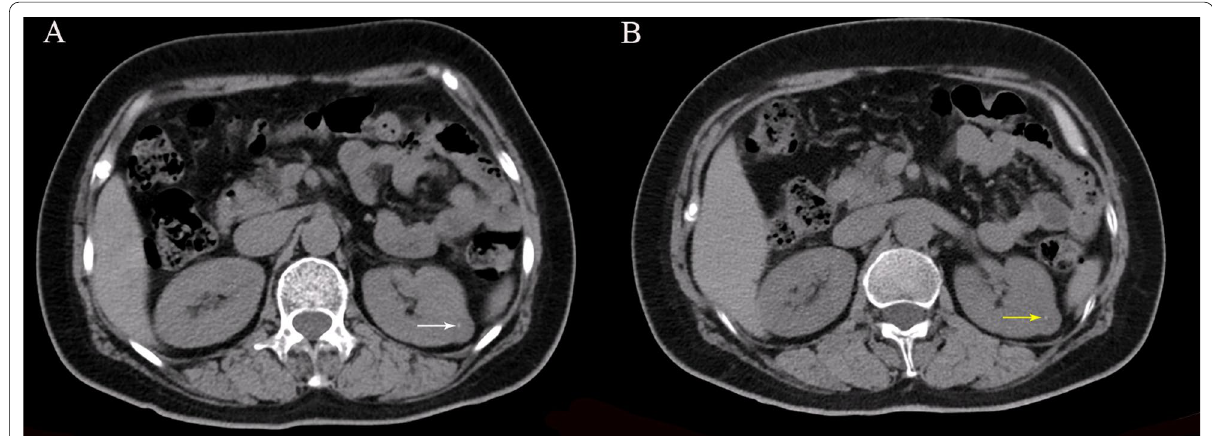
Fig. 3 The images of a 56-year-old woman with clear cell carcinoma of the left kidney showed clear microscopic calcification on both TNC ( A ) and VNC images ( B )